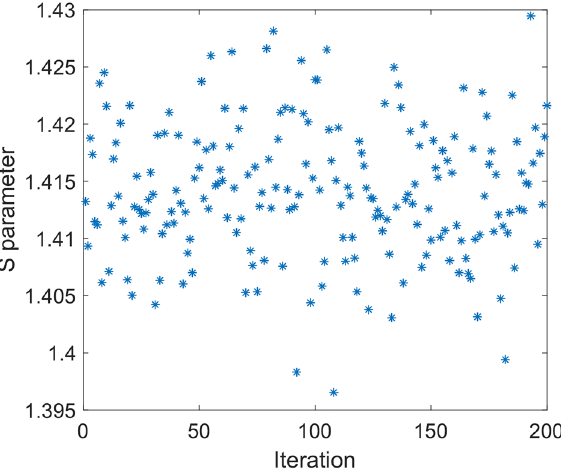
Figure 5. S parameter for 200 iterations for the local model. In each run input to each polarizer is a vector with size 100,000. Based on (15), signa l and idler vectors are equal. Mean value of S parameter in this example is equal to 1.414 while angles of polarizers are α 1 = 3 π/ 8, β 1 = π/ 4, α 2 = π/ 8, β 2 =